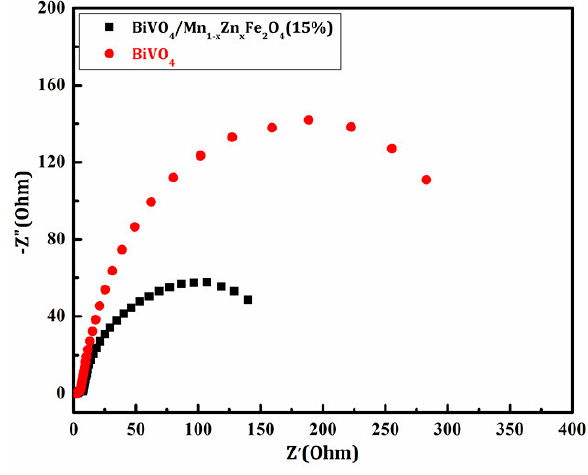
Figure 8. The Nyquist plots of BiVO 4 and BiVO 4 /Mn 1 − x Zn x Fe 2 O 4 (15 wt %).